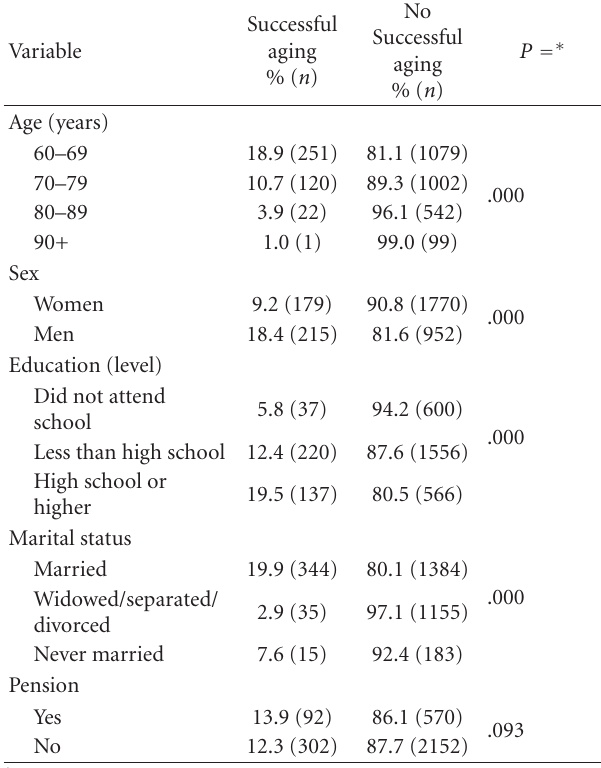
Table 3: Successful aging by age, sex, education, marital status and